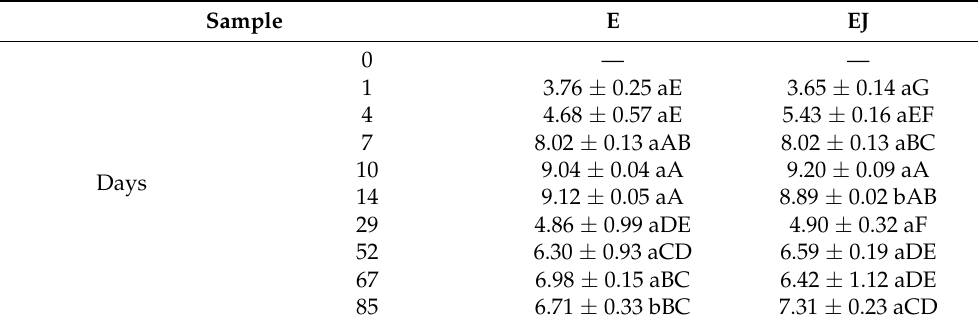
Table 7. Growth of AMB (log cfu/g) in chicken broth during storage for 85 days: with 8% spray-dried extract (E); with 8% of spray-dried extract and inoculum (EJ). Sample E EJ 0